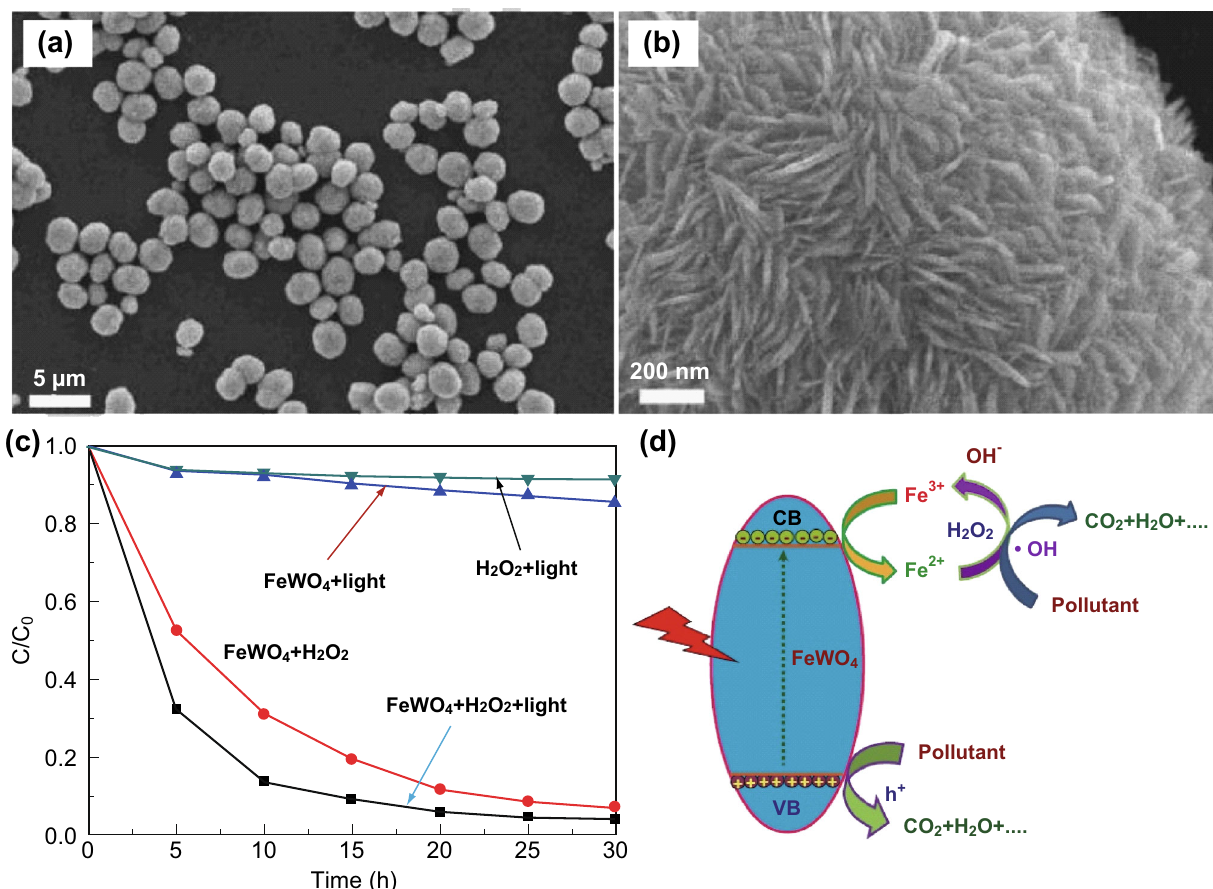
Fig. 10 a , b FESEM images of FeWO 4 microspheres. c Photocatalytic performance of FeWO 4 microspheres for the degradation of RhB. d Schematic illustration of photocatalysis mechanism for FeWO 4 microspheres. Reproduced with permission from Ref. [112]. Copyright 2016